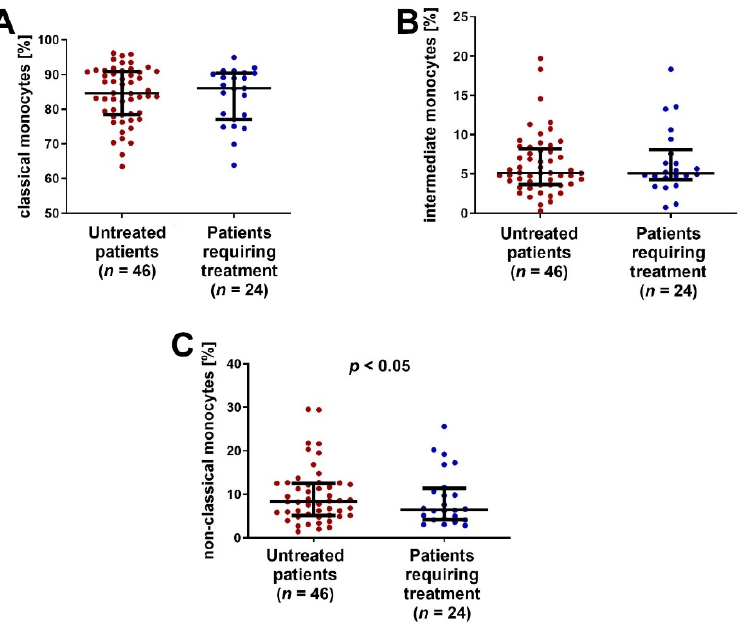
Figure 3. Comparison of the percentage of ( A ) classical, ( B ) intermediate and ( C ) non-classical monocytes in CLL patients at different stages of disease advancement. The solid line marks the median value. Ɪ represents the interquartile range (IQR).